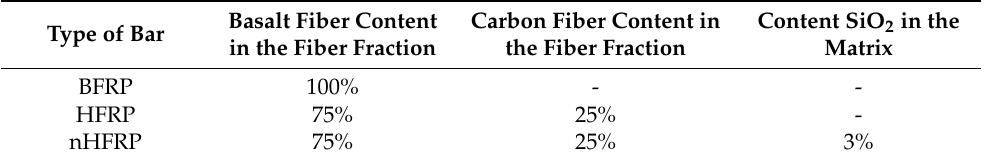
Table 1. Types of tested bars BFRP (basalt fiber-reinforced polymer), HFRP (hybrid basalt-carbon fiber-reinforced polymer), and nHFRP (hybrid bars modified nano silica). Basalt Fiber Content Carbon Fiber Content in Content SiO 2 in the Type of Bar in the Fiber Fraction the Fiber Fraction Matrix BFRP 100% - - HFRP 75% 25% - nHFRP 75% 25%